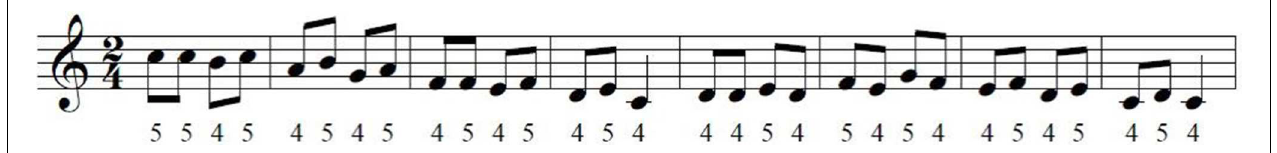
FIGURE 1 | The small-weak condition (SW): small hand span (i.e., fingers are at their natural resting positions) with only weak fingers, i.e., the ring (4) and little (5) fingers involved.